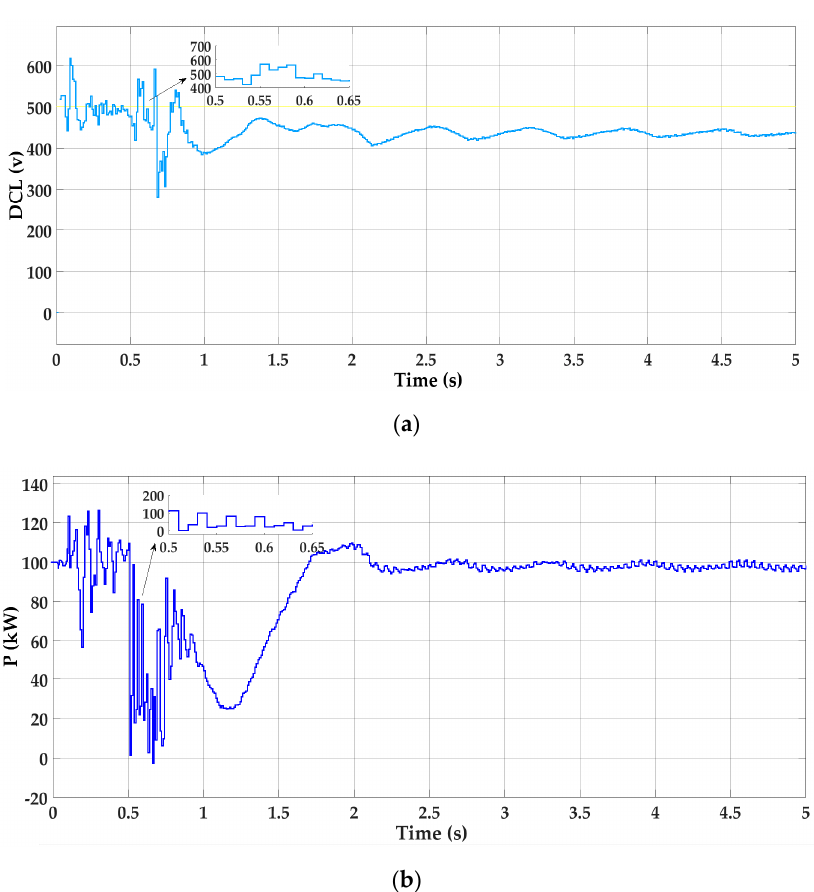
Figure 18. Simulation results of the DC-breaking chopper control scheme. ( a ) DC-link voltage (DCL), ( b ) active power (P).